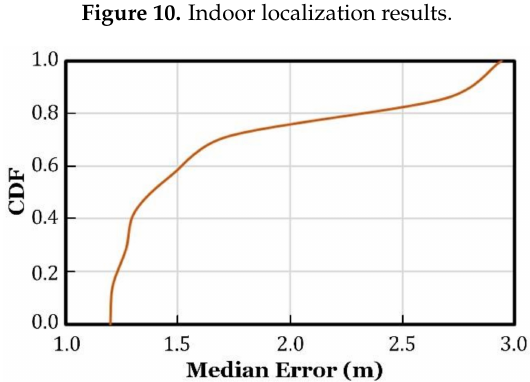
Figure 11. The cumulative distribution function (CDF) of localization